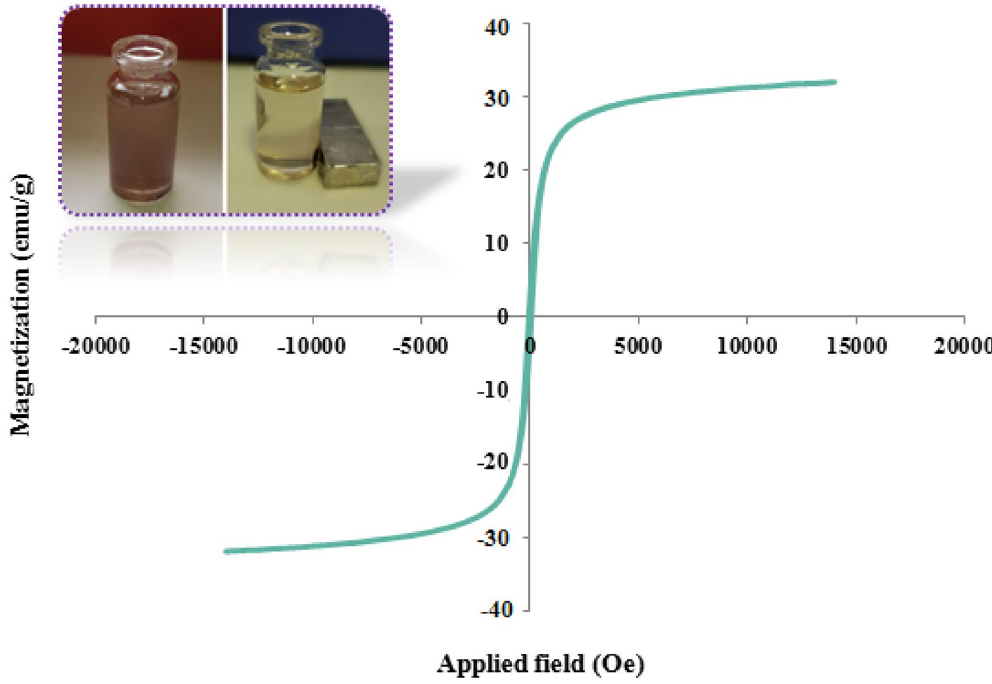
Figure 3. VSM analysis of n-Fe 3 O 4 @SiO 2 -TA-SO 3 H